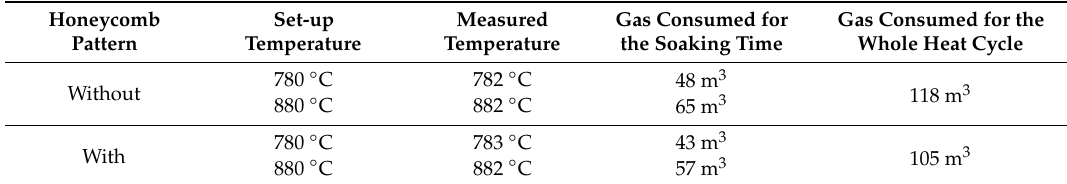
Table 6. The average amount of gas consumed to maintain 780 ◦ C and 880 ◦ C for 1440 min and for an entire heat cycle (3000